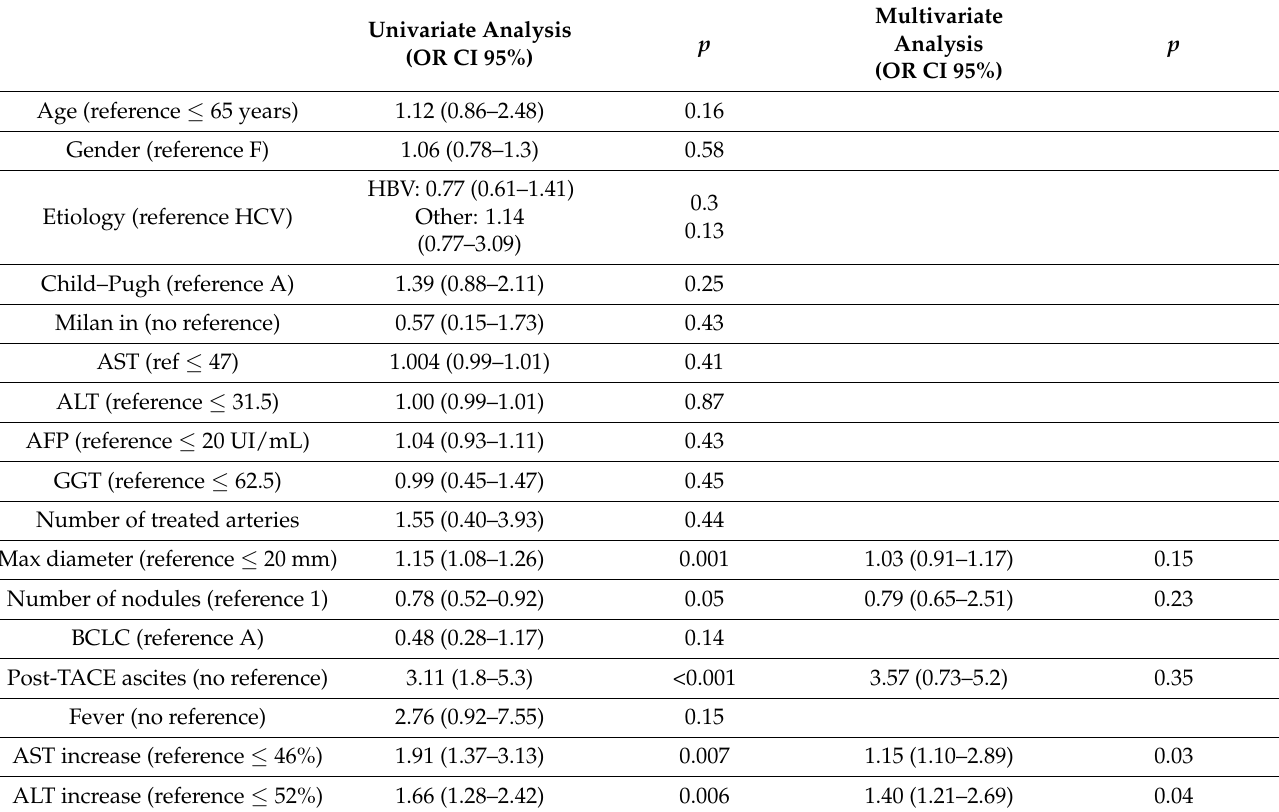
Table 3. Univariate and multivariate logistic regression analyses for the assessment of clinical, laboratory, and procedural data associated with objective response when considering only the response of the target lesions (lesions treated with conventional chemoembolization).